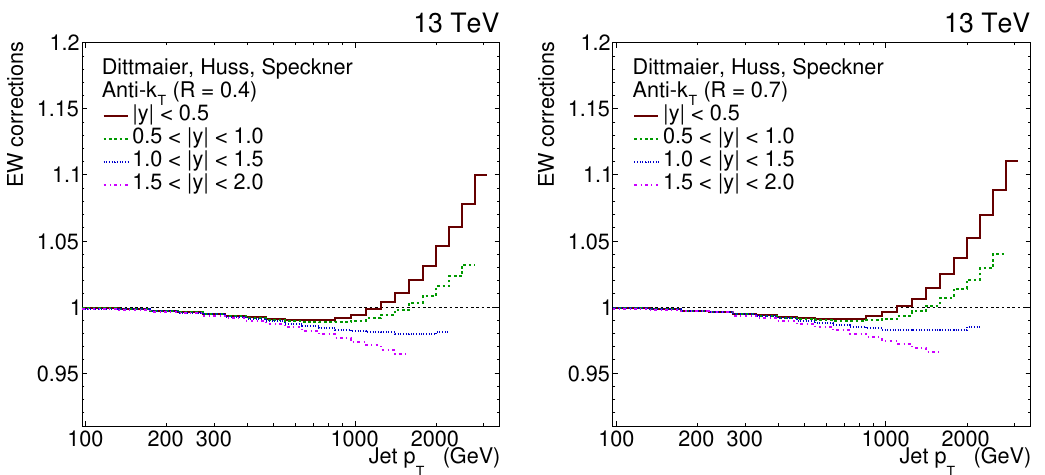
Figure 4 . The EW corrections for inclusive jet cross sections, as reported in ref. [62]. The values for jets clustered using the anti- k algorithm with R = 0 . 4 (0.7) are shown on the left (right); each T curve corresponds to a rapidity bin.